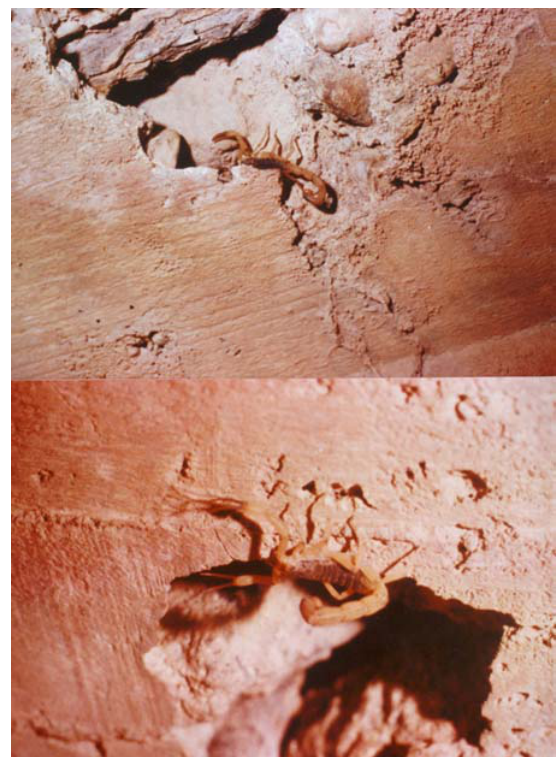
Figure 18. Parthenogenetic female of Tityus serrulatus in the sewer system of Brazilian